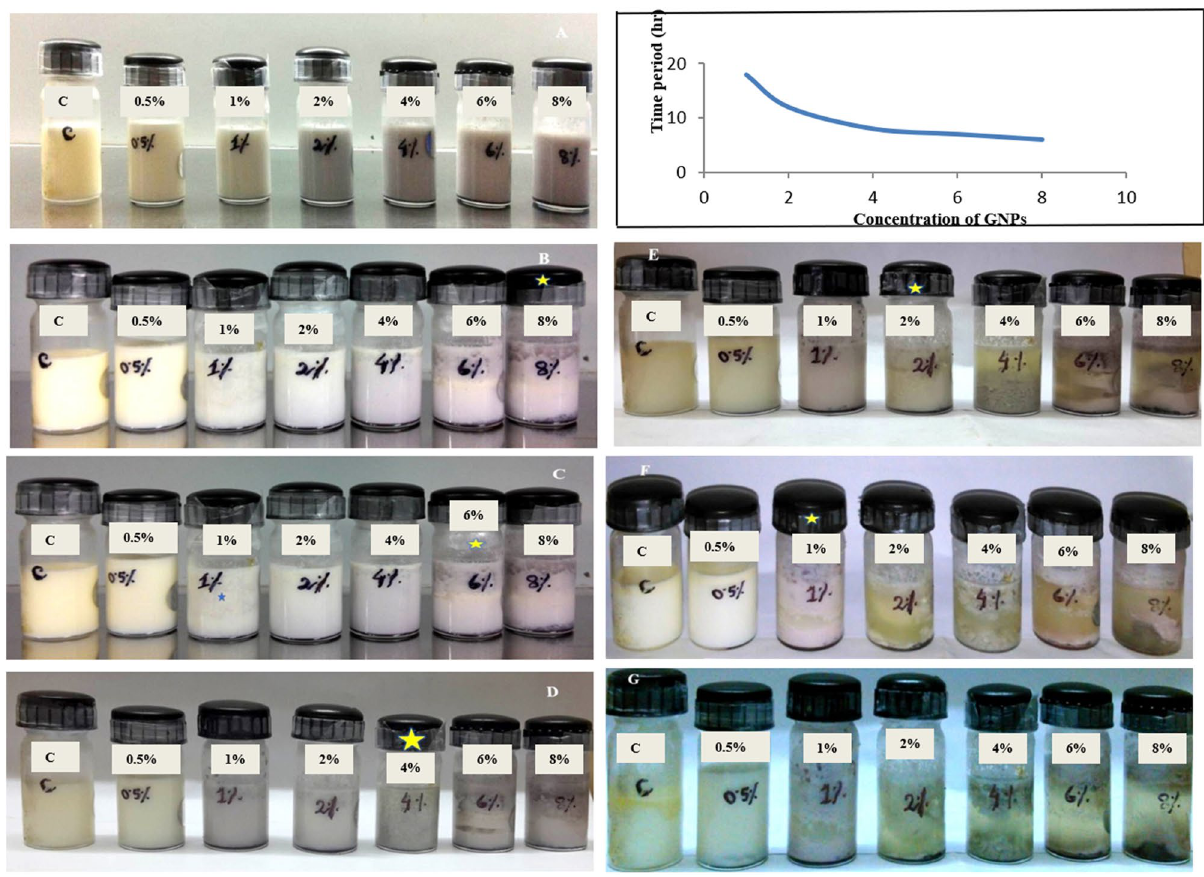
Figure 8. Milk clot assay ( A – G ) with different concentrations of prismatic gold nanozymes (0.5, 1, 2, 4, 6 and 8%) upto 72 h with images taken at initiation of curdling; inset: histograms showing initiation of curdling.